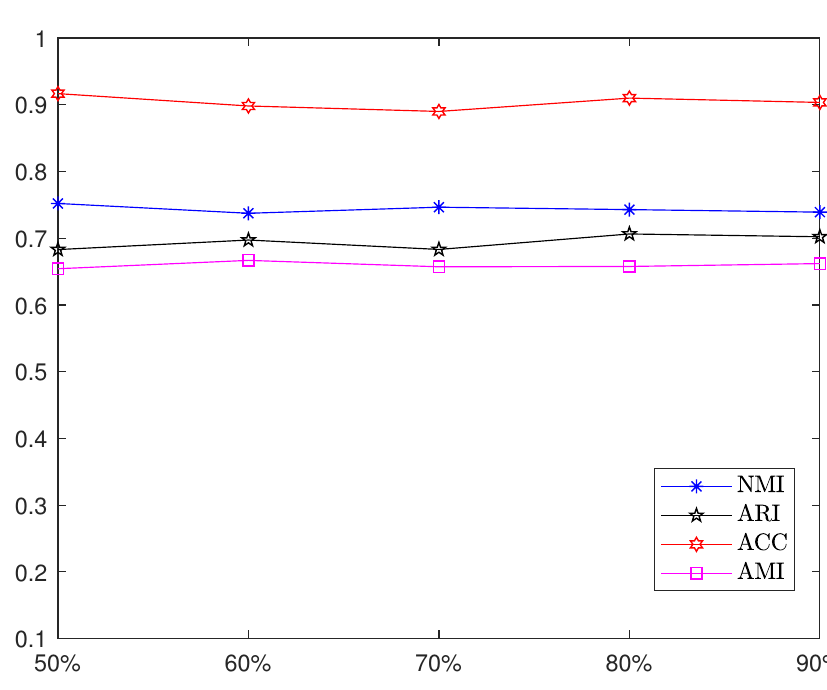
Figure 3. Results of Congressional Voting by